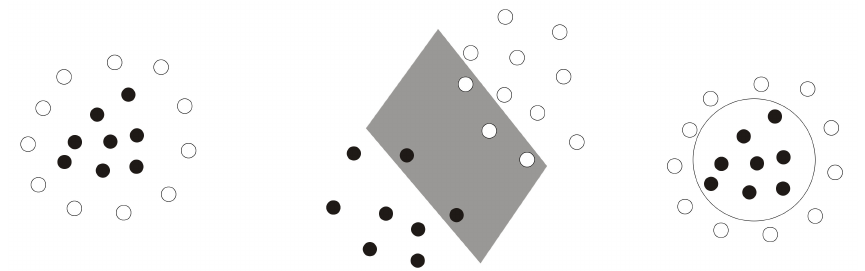
Figure 7. The kernel transformation (trick) process. A non-linear data space (left) is mapped, through a non-linear kernel, into a new linear separable data space (right). Source: Adapted from [49] and prepared by the authors.